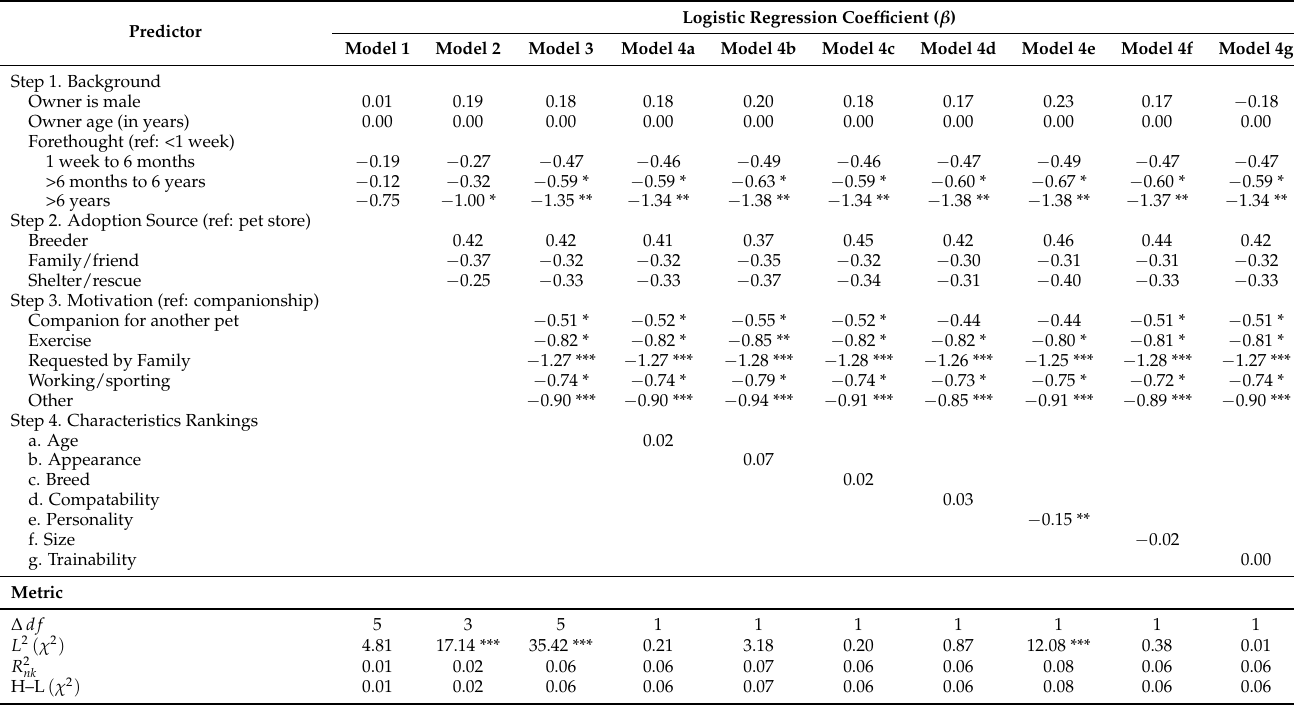
Table 2. Hierarchical regression analysis of adoption criteria on owner